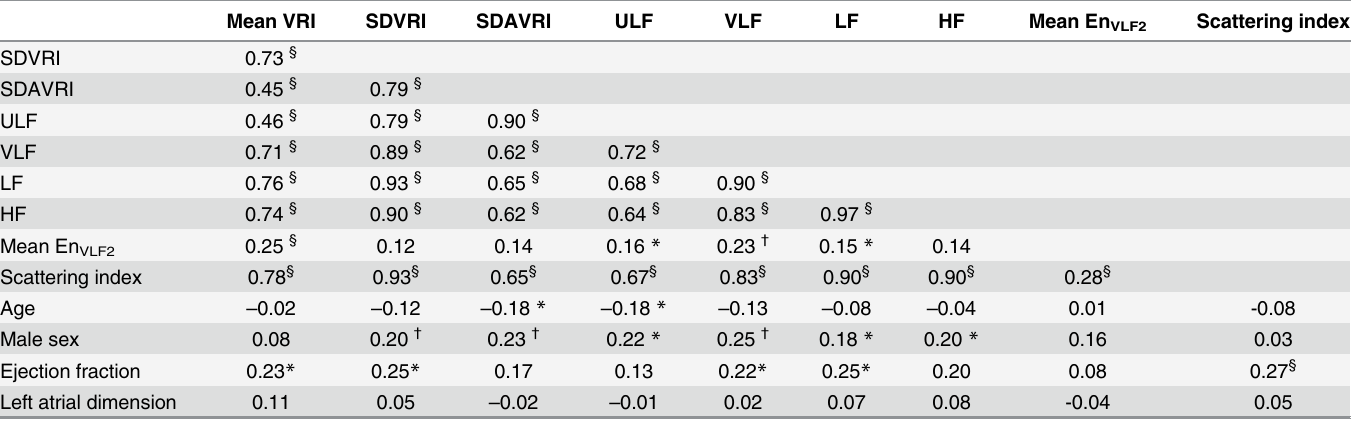
Table 3. Relationships between the clinical features and VRI